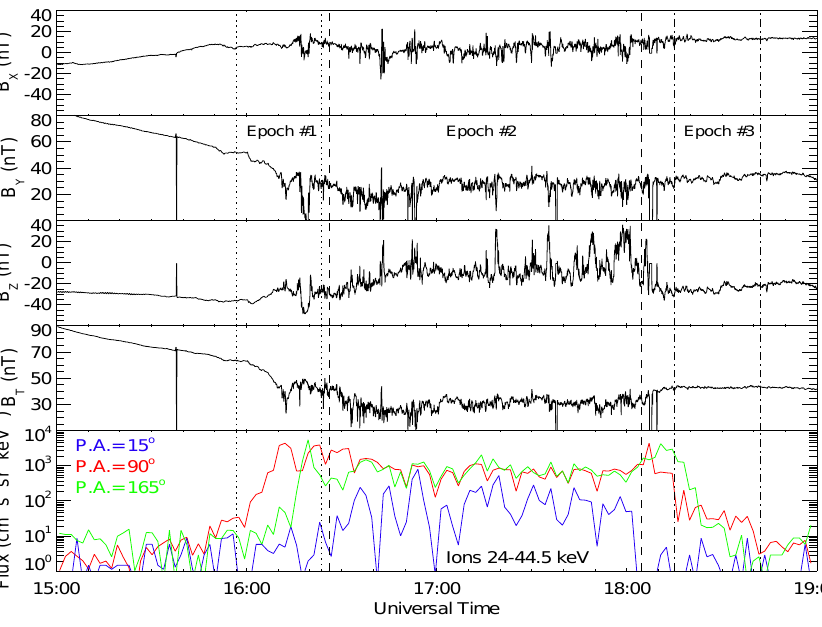
Fig. 1. The GSM ˆX, ˆY, and ˆZ magnetic field components (top 3 panels, respectively) and the total magnetic field (panel 4) observed by ISEE-1 from 15:00–19:00 UT on 30 October 1978. The bottom panel contains the proton flux for 24–44.5keV energy channel, where the particles are sorted by their pitch angles, particle detected at a pitch angle of 15 ◦ is blue, 90 ◦ is red, and 165 ◦ is green, with a tolerance of ± 5 ◦ . The dotted lines correspond to the time period for Fig. 3, dashed lines for Fig. 4, and dot-dashed line for Fig. 5.